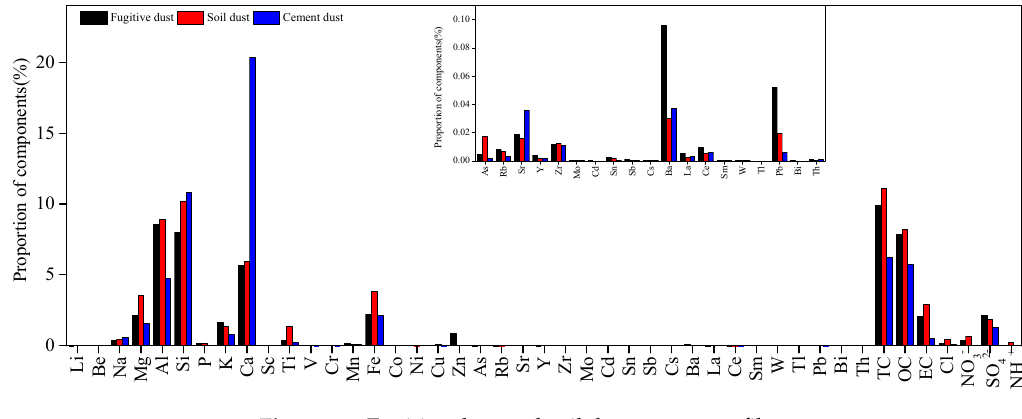
Figure 9. Proportion of major species in PM 2.5 in four pollution days.